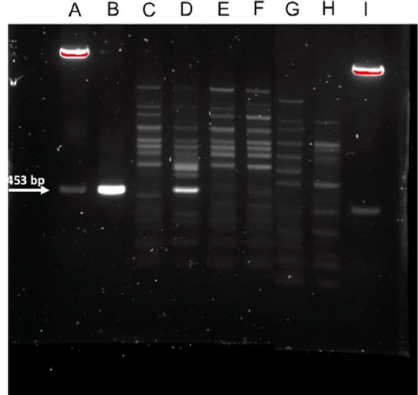
Figure 2. SCAR-2 primer amplification products resolved on 1.5% agarose gel. Lane